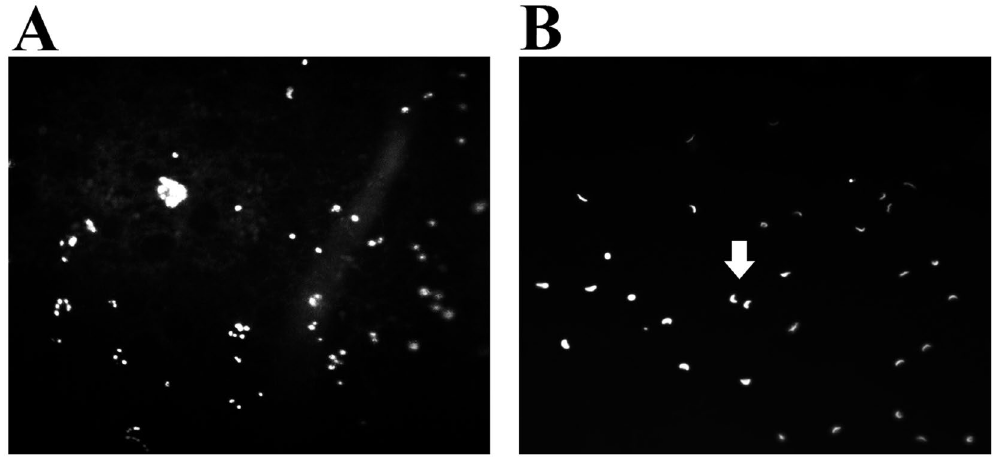
Figure 2. Fluorescent Hoechst 33342 staining of the maternal cells and sperms on the VM. ( A ) The maternal cells on the VM of the unfertilized eggs ( × 200). ( B ) The sperms on the VM of the fertilized eggs ( ×